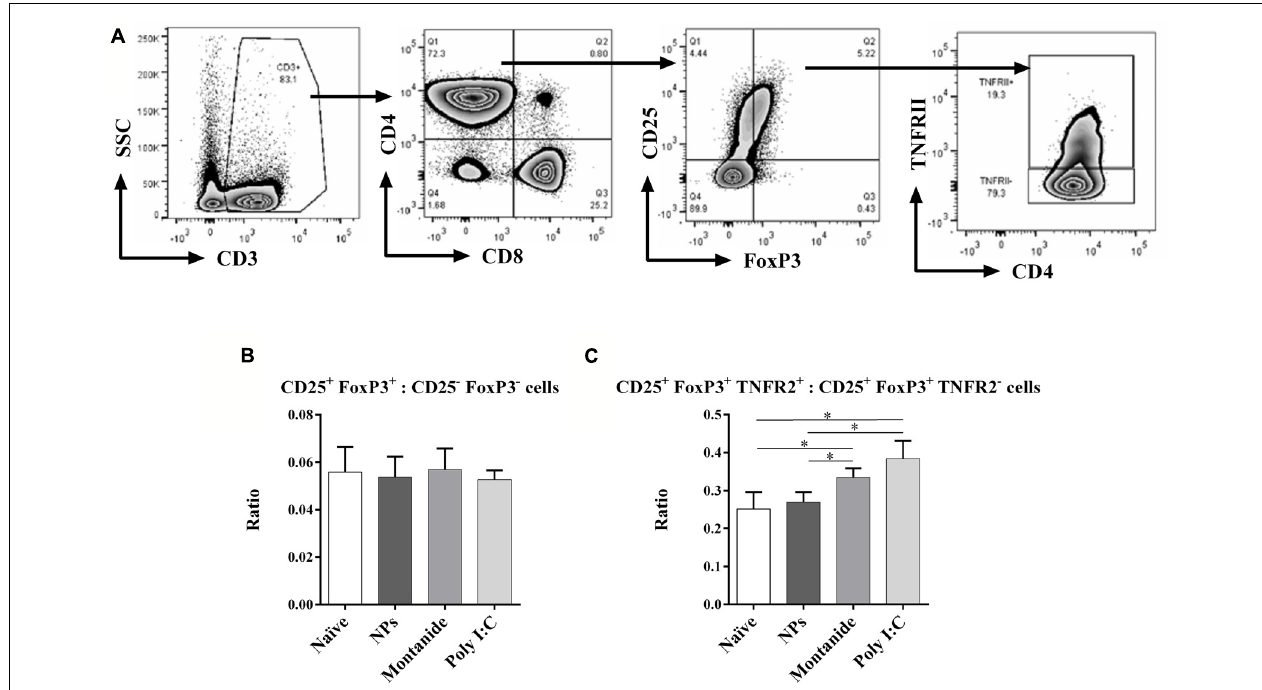
cytometry. (A) gating strategy; (B) ratio of FoxP3 + CD25 + : FoxP3 − CD25 − cells; (C) ratio of FoxP3 + CD25 + TNFR2 + : FoxP3 + CD25 + TNFR2 − cells. Data presented as mean ± SD of ratio for each group of treatment ( n = 3 mice/group). Statistical analysis was performed via t -tests, * p ≤